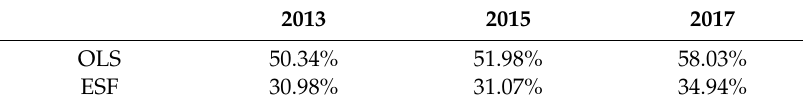
Table A5. LOOCV MARE of the OLS and ESF without NTL variable.